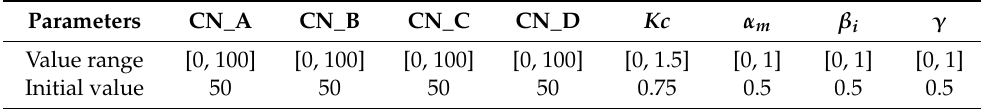
Table 5. Model value ranges and initial